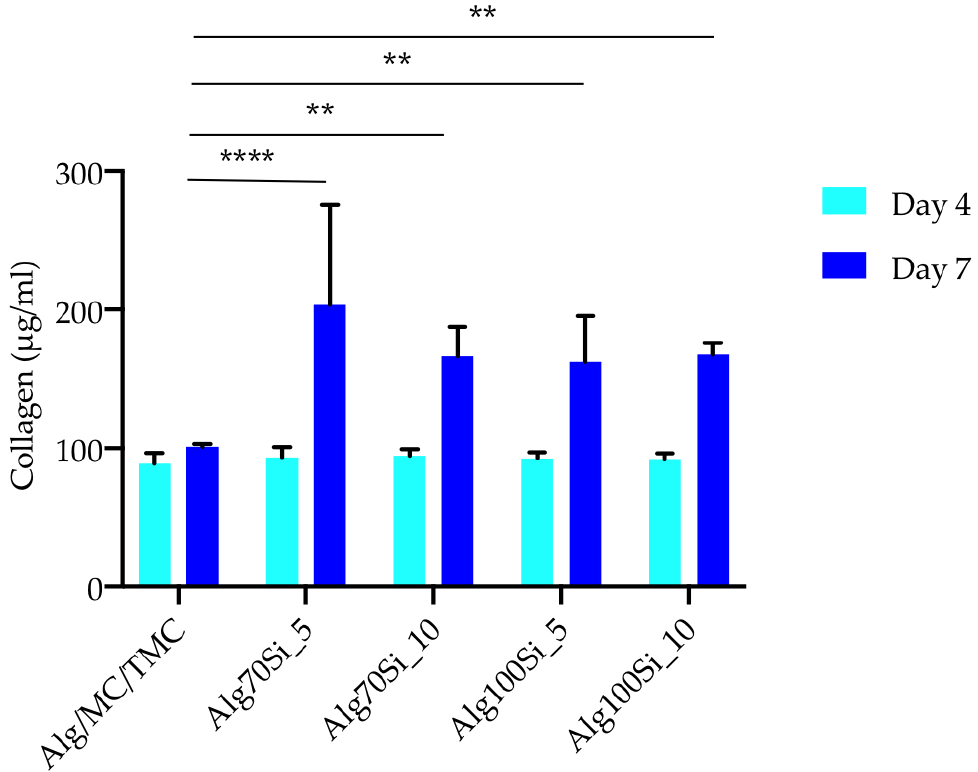
Figure 10. Levels of total collagen produced by MC3T3-E1 pre-osteoblastic cells cultured on the five scaffolds for 4 and 7 days. The values represent means ± standard deviations of triplicates ( n = 3), and the asterisks indicate statistical significance compared to the Alg/MC/TMC control surface at each experimental time point (**: p < 0.01, ****: p < 0.0001).